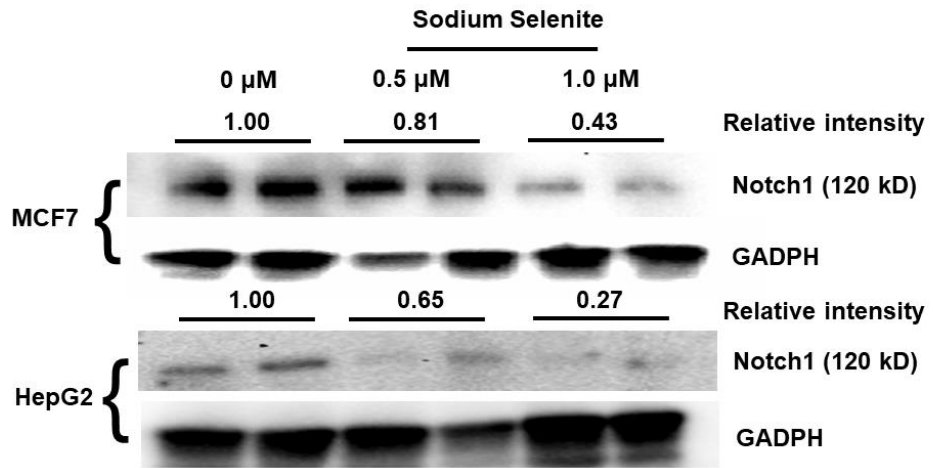
Figure 2. Selenite inhibits Notch1 protein expression in mammalian cancer cell lines MCF7 and HEPG2. Selenite was added to culture at indicated concentrations overnight, and cells were collected for the Western blot. Western blot of treated MCF7 shows a decrease in Notch1 intracellular/transmembrane region (NTM) expression at 1.0 µ M after 24 h in MCF7 cultures ( n = 2). HEPG2 at both 0.5 µ M and 1.0 µ M showed a decrease in Notch1 (NTM) expression after 24 h ( n = 2). GAPDH was utilized as the loading control for all cell sample data. Averages of replicates in their relative expression (Notch1 versus GADPH) are indicated in the figure for easy comparison.